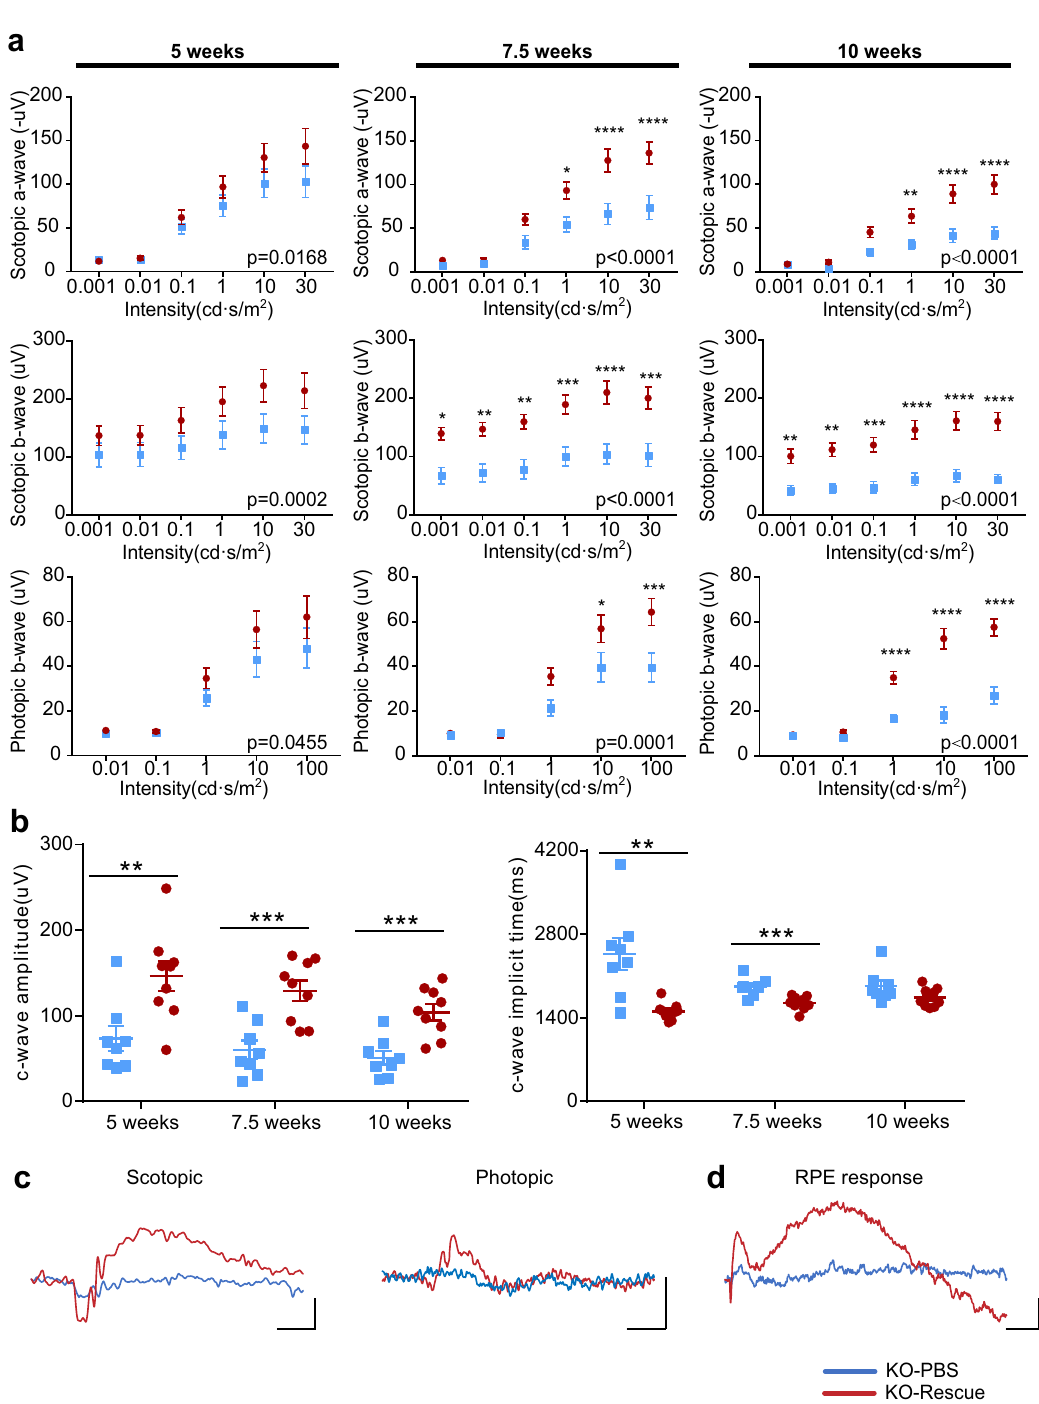
Data were shown as mean±SEM. The signi fi cance of the overall treatment factor wascalculatedbytwo-wayANOVAandshownasa P valueineachplot.Signi fi cance of the treatment factor at each fl ash intensity was calculated by Sidak multiple comparisons test and marked as * P <.05; ** P <.01; *** P <.001; **** P <.0001. Data of ERG c-waves were analyzed using a two-tailed unpaired t -test. Source data are provided as a Source Data fi